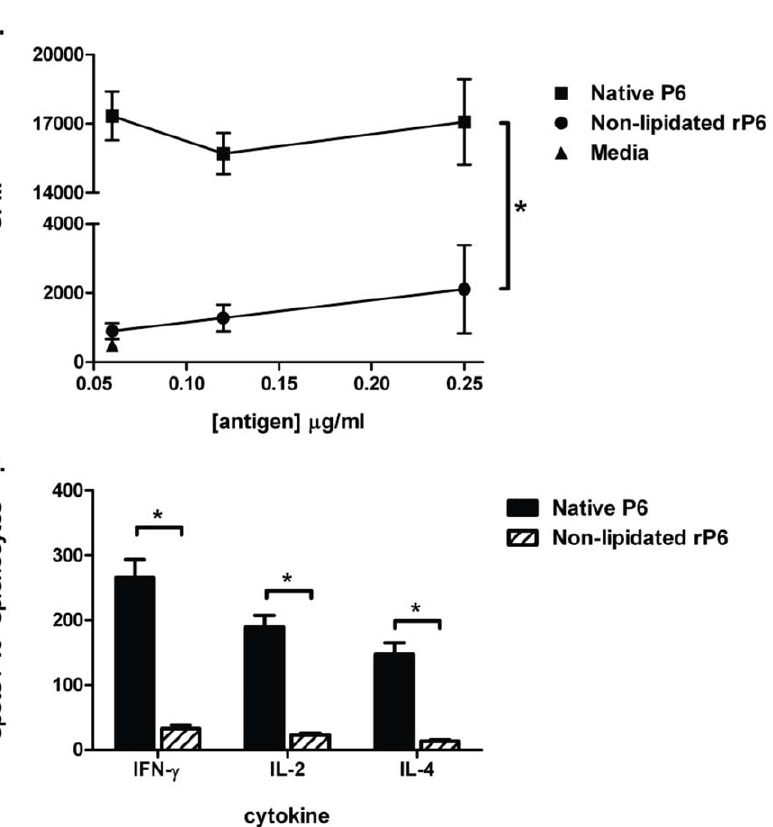
Figure 3. Lipid motif on P6 augments T cell proliferation and cytokine production. WT mice were immunized s.c. with 40 m g of native P6 emulsified in CFA and IFA one week later. ( A ) Proliferation of CD3 + cells isolated from draining lymph nodes was measured following 4 day co-culture with syngeneic irradiated BMDCs pulsed with 0.25, 0.12, and 0.06 m g/ml native P6 ( & ) or non-lipidated rP6 ( performed for background proliferation of T cells. Thymidine was added to the wells for the last 16 hrs of incubation. ( B ) Splenocytes from the same animals were co-cultured overnight with 0.06 m g/ml antigen pulsed irradiated BMDCs in ELISPOT plates coated with anti-cytokine mAb. Plates were developed and spots enumerated microscopically. *p , 0.01 1way ANOVA with Bonferroni post-test comparison of native P6 to non-lipidated rP6.